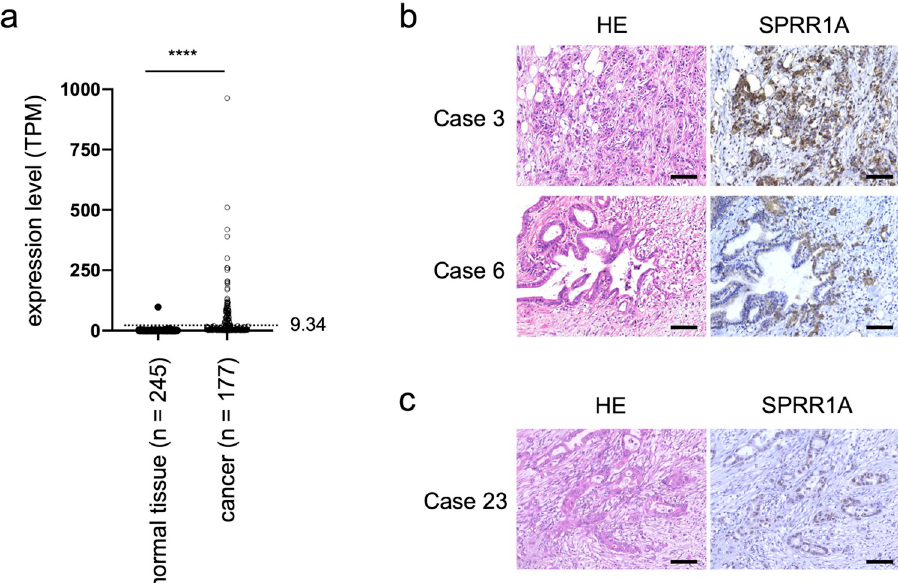
Fig 1. The expression of SPRR1A in PDAC. (a) The comparison of the SPRR1A expression (TPM) between normal pancreas tissue (n = 245) and pancreatic cancer (n = 177). The SPRR1A expression was elevated in 89 of 177 cases. ���� p < 0.0001, unpaired t -test. The dotted line shows TPM 9.34, the second-highest expression in normal pancreas tissue. (b) Representative cases from the SPRR1A high expression group in PDAC (Cases 3 and 6). Scale bars, 500 μ m. (c) Representative case from the SPRR1A low expression group in PDAC (Case 23). Scale bars, 500 μ